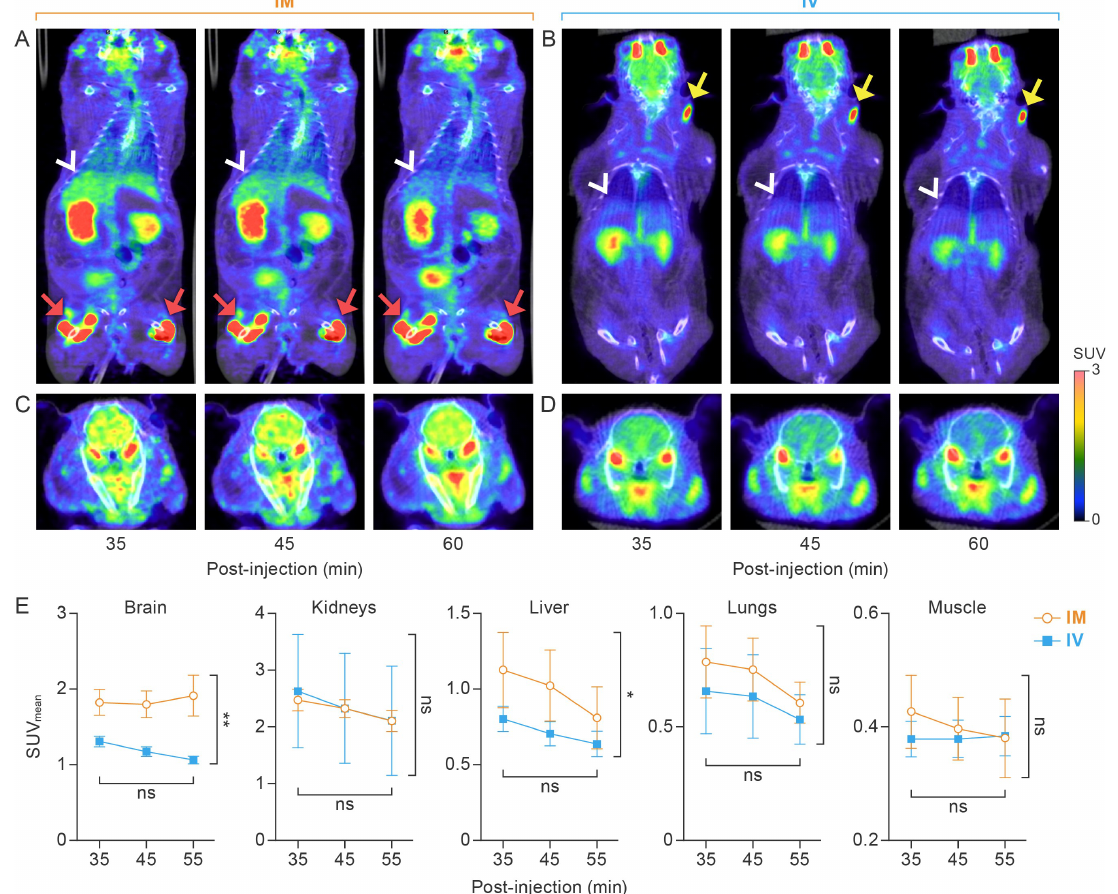
Figure 3. Comparison of [ 18 F]F-FDG distribution at different time points after IM or IV administration. ( A ) Coronal section of whole-body PET at 35, 45, and 60 min post-injection via the IM route. White arrowheads point to the liver. Red arrows show [ 18 F]F-FDG residual/extravasation representative of that found in the IM group, respectively. ( B ) Coronal section of whole-body PET at 35, 45, and 60 min post-injection via the IV route. White arrowheads point to the liver. Yellow arrows show [ 18 F]F-FDG residual/extravasation representative of that found in the IV group. ( C ) Trans-axial section images of the brain at 35, 45, and 60 min post-injection via the IM route. ( D ) Trans-axial section images of the brain at 35, 45, and 60 min post-injection via the IV route. All images are from a single golden hamster that received IM and IV administration on different days. ( E ) Two-way ANOVA indicates that the IM route results in increased [ 18 F]F-FDG accumulation in the liver ( p = 0.03) and brain ( p = 0.005) as compared to the IV group. [ 18 F]F-FDG accumulation in lungs, kidney, and muscle tissue was not statistically different between IM and IV routes. [ 18 F]F-FDG, 2-deoxy-2-[ 18 F]fluoro-D-glucose; IM, intramuscular; IV, intravenous; PET, positron emission tomography; ANOVA, analysis of variance. *, p < 0.05; **, p <